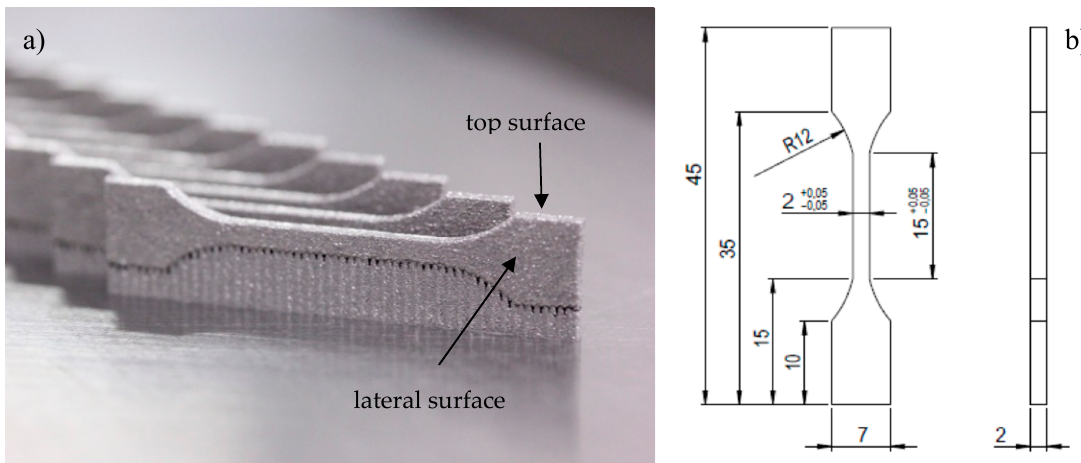
Figure 1. Samples: for tensile test ( a ); dimensions in mm ( b ) of tensile samples.